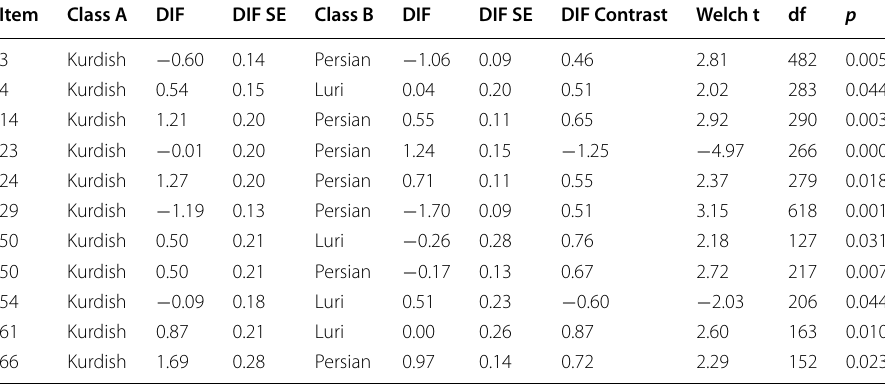
Table 4 Results of uniform DIF analysis of items (IUUESEE